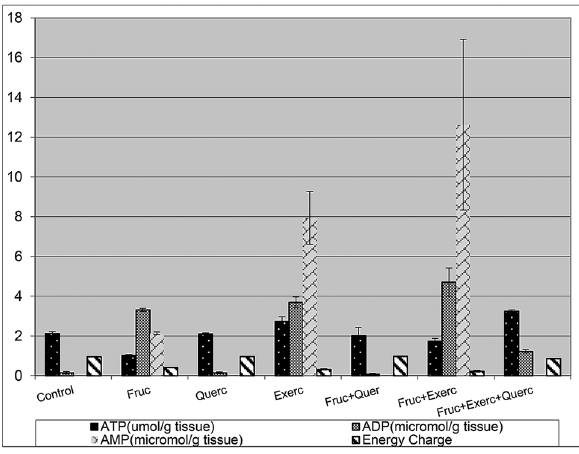
Figure 1: ATP, ADP, AMP levels and energy charge in muscle When the energy charge of the Control group and the other groups were compared, the energy charge decreased in Fructose, Exercise, Fructose + Exercise groups (Table 3). In